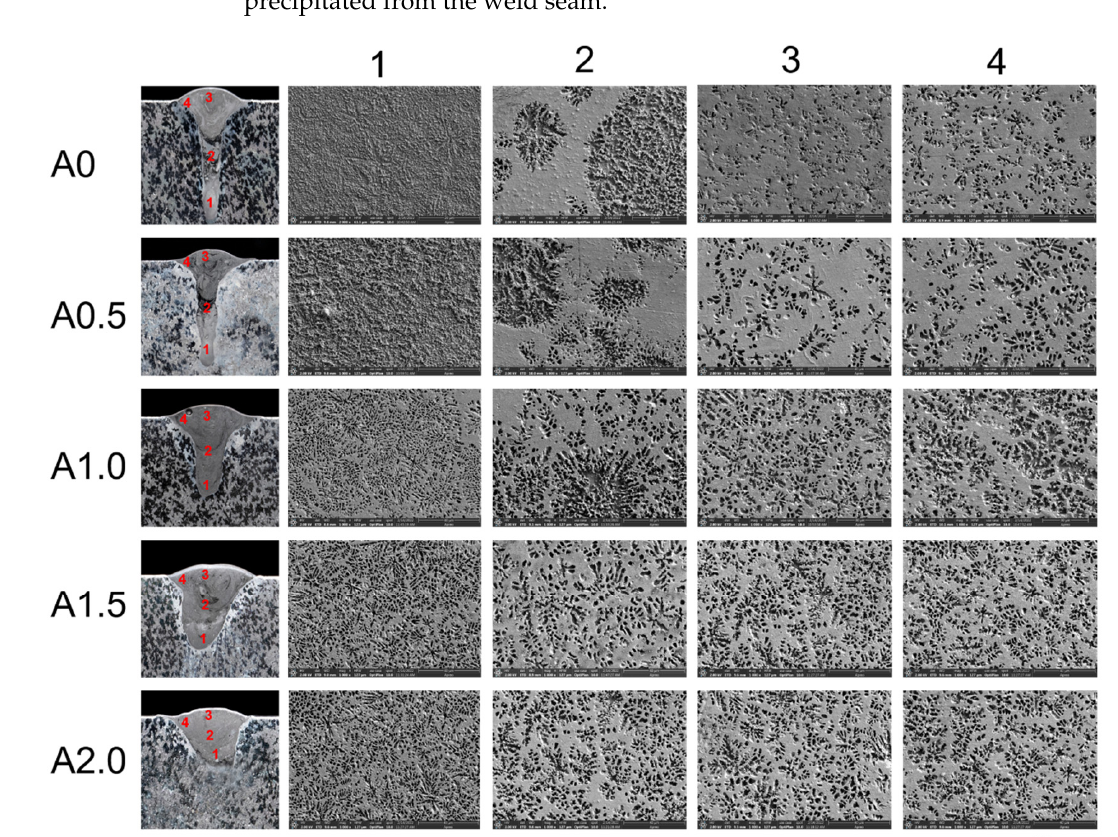
Figure 6. SEM image of the weld seam cladded with different oscillating amplitudes.